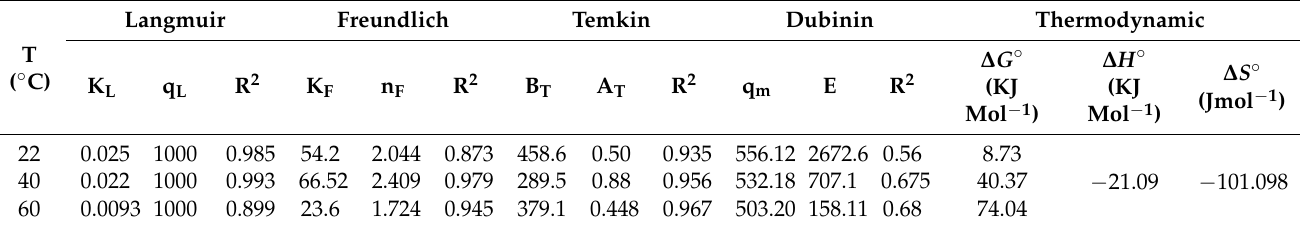
Table 4. Adsorption isotherm constants and thermodynamic